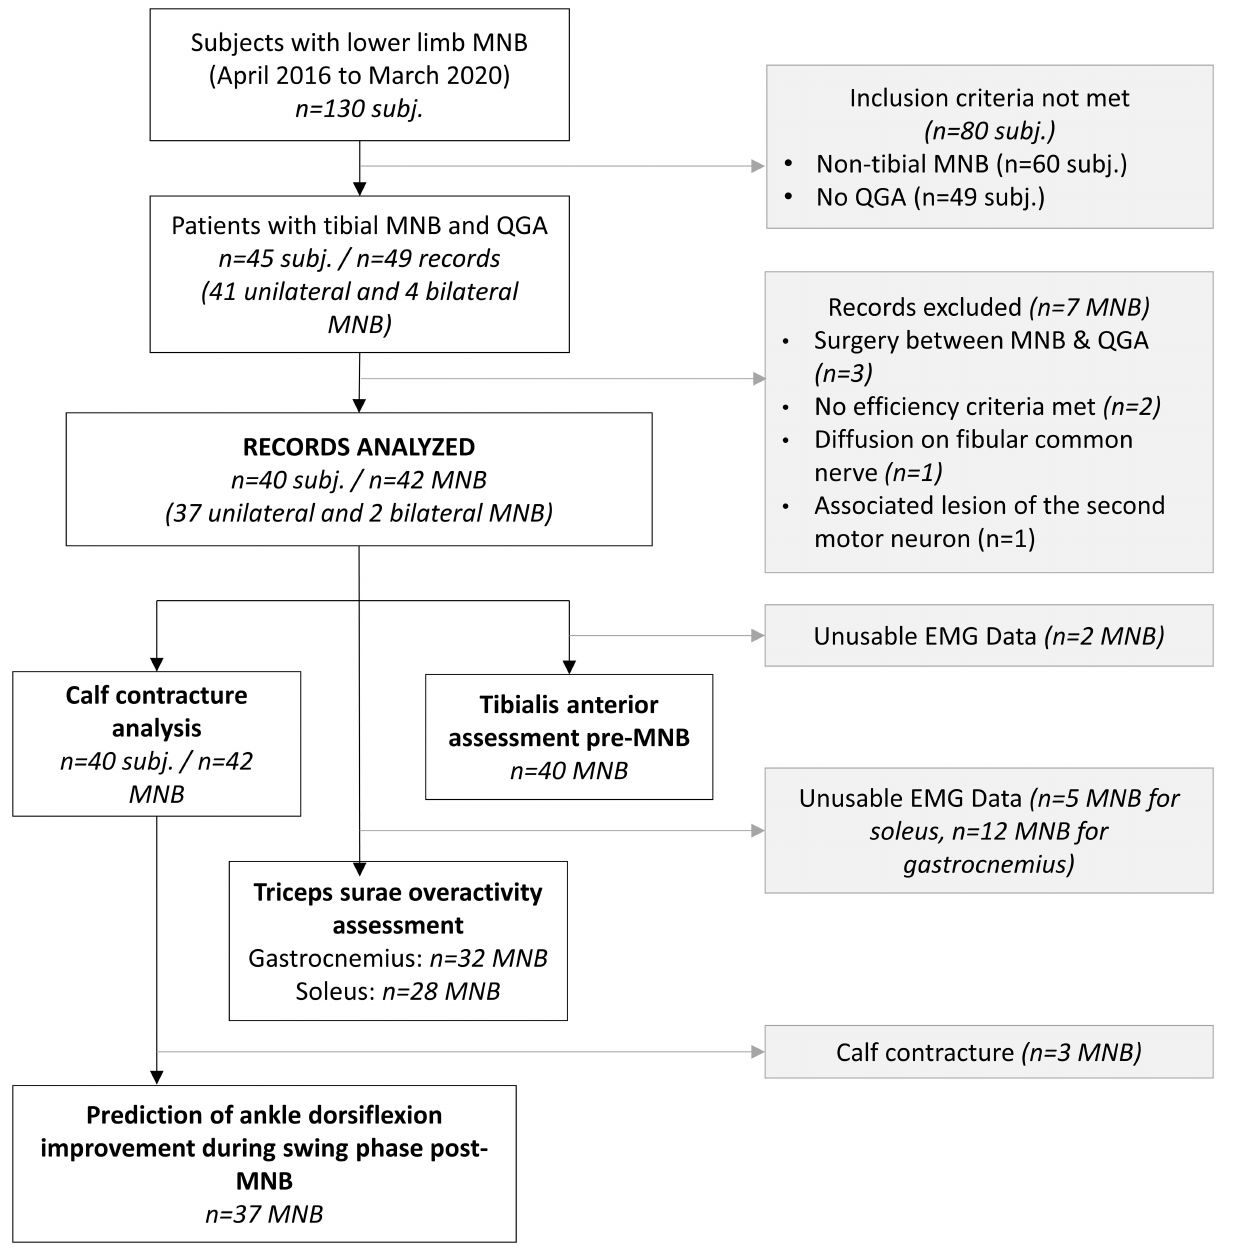
included in the analysis (refer to the flowchart